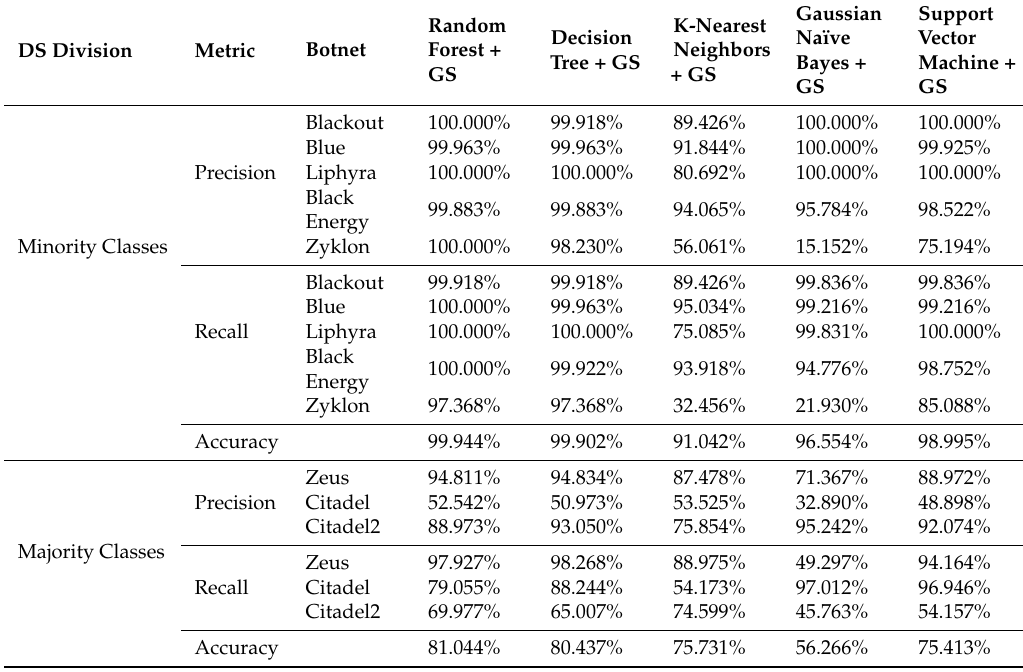
Table 7. Comparative analysis of minority and majority classes on the ISOT HTTP Botnet